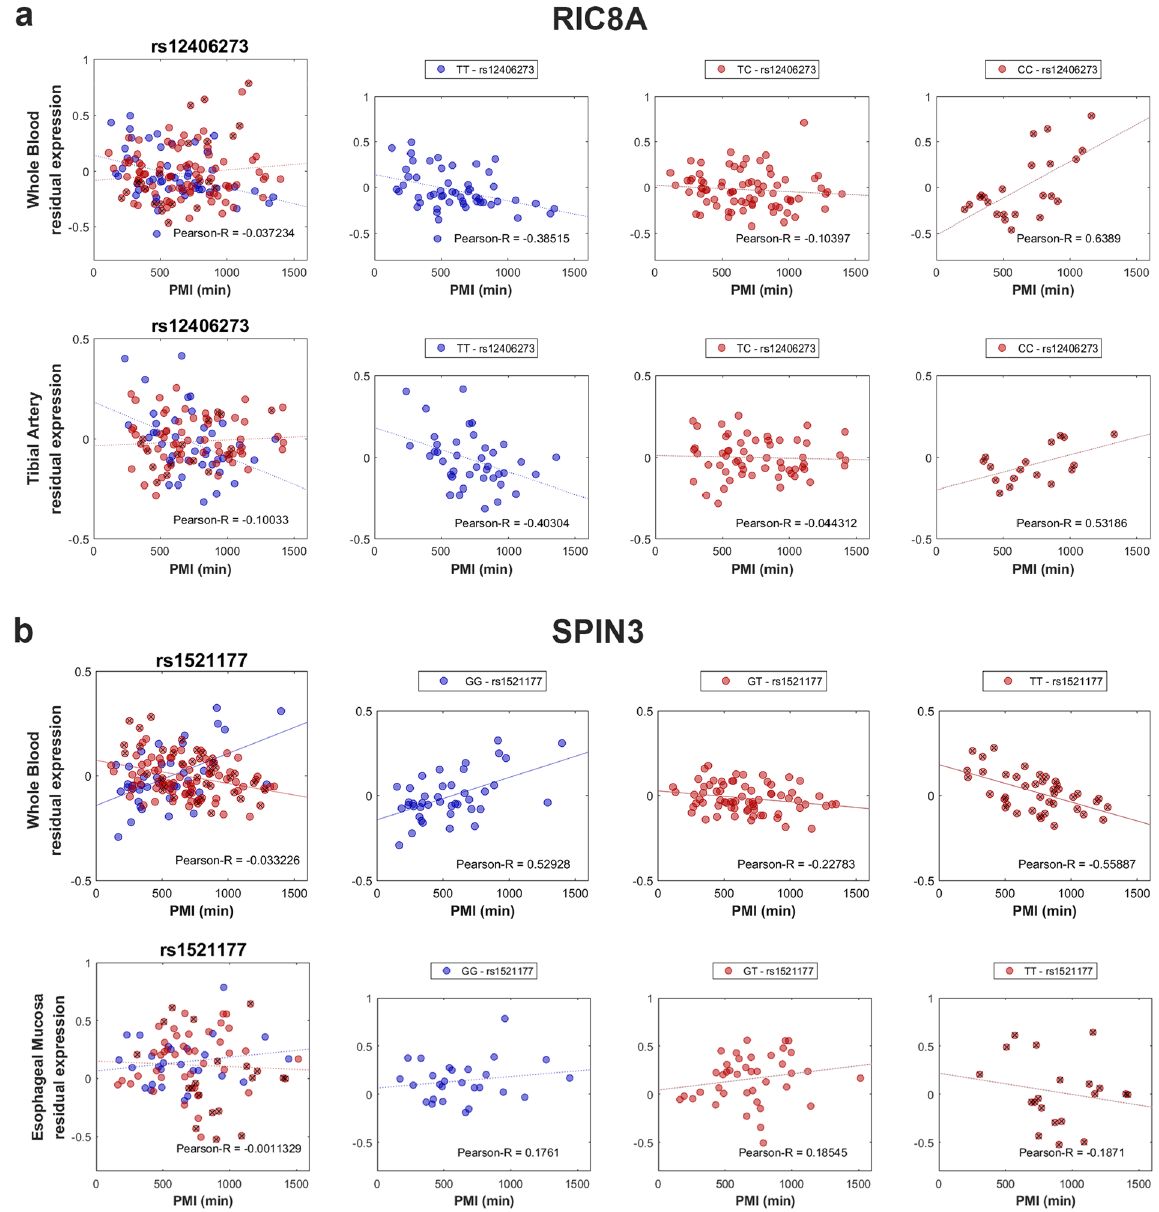
Figure 3. Examples of genotype-by-PMI interaction affecting the expression level of the gene. ( a ) The interaction between rs12406273 and PMI affecting RIC8A gene expression in tibial artery and whole blood. ( b ) The interaction of rs1521177 and PMI affecting SPIN3 gene expression in esophageal mucosa and whole blood. For each subplot, the larger panel on the left shows all samples, while the three smaller panels on the right show the samples with major allele homozygous, heterozygous and minor allele homozygous (with a cross)